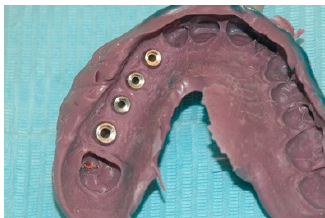
Figure 5. Impression and structure made.